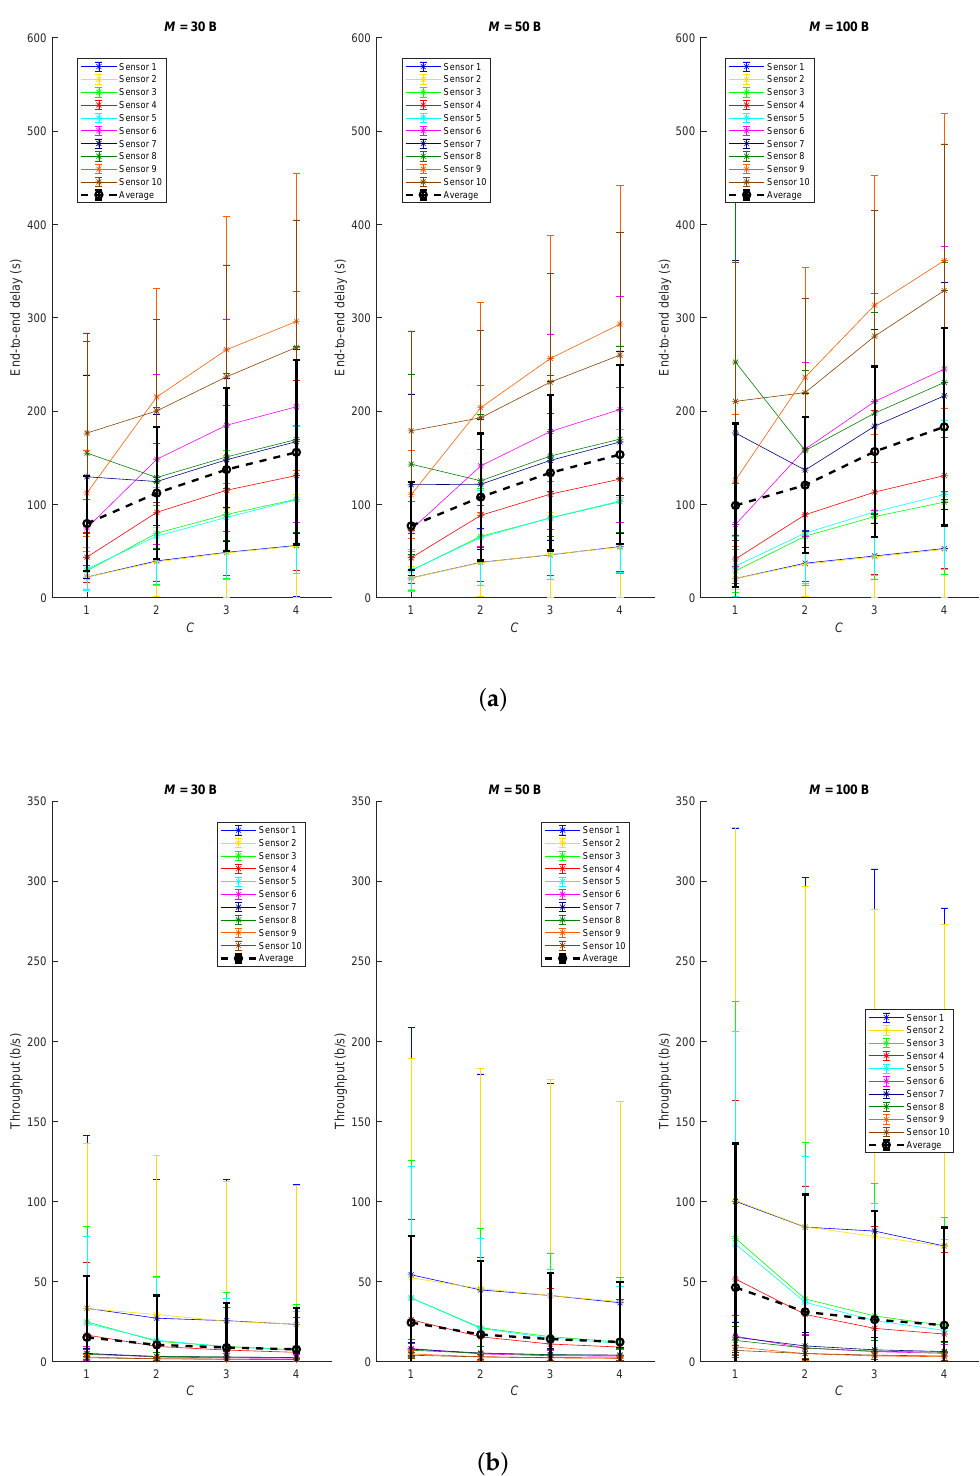
Figure 10. Results for the Testbed1 ( a ) average end-to-end delay and ( b )